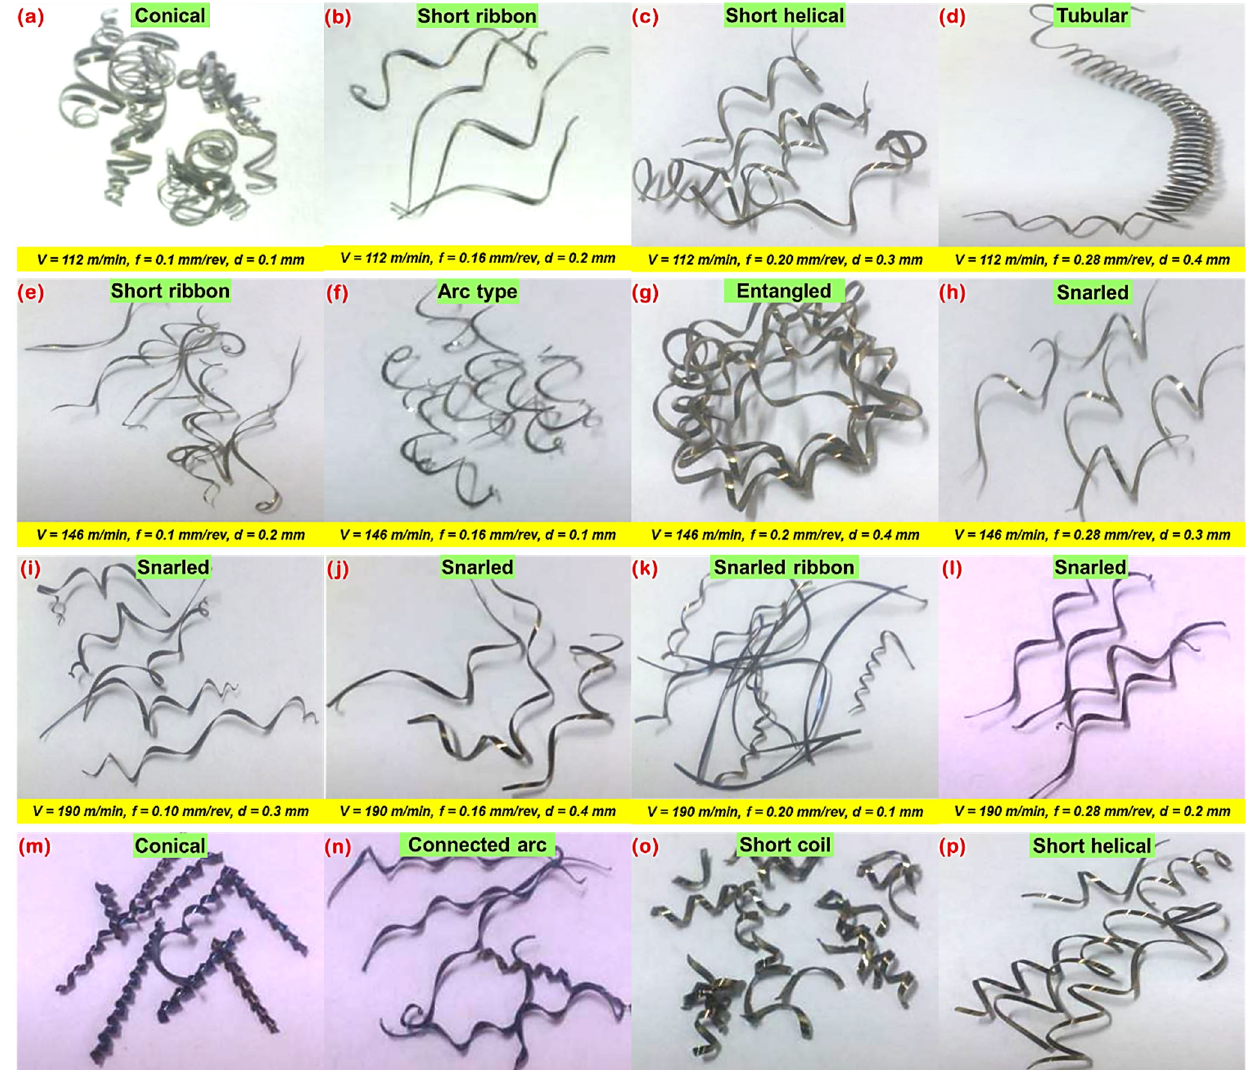
Figure 10. Photograph of c hips at various feed rates and cutting speeds.